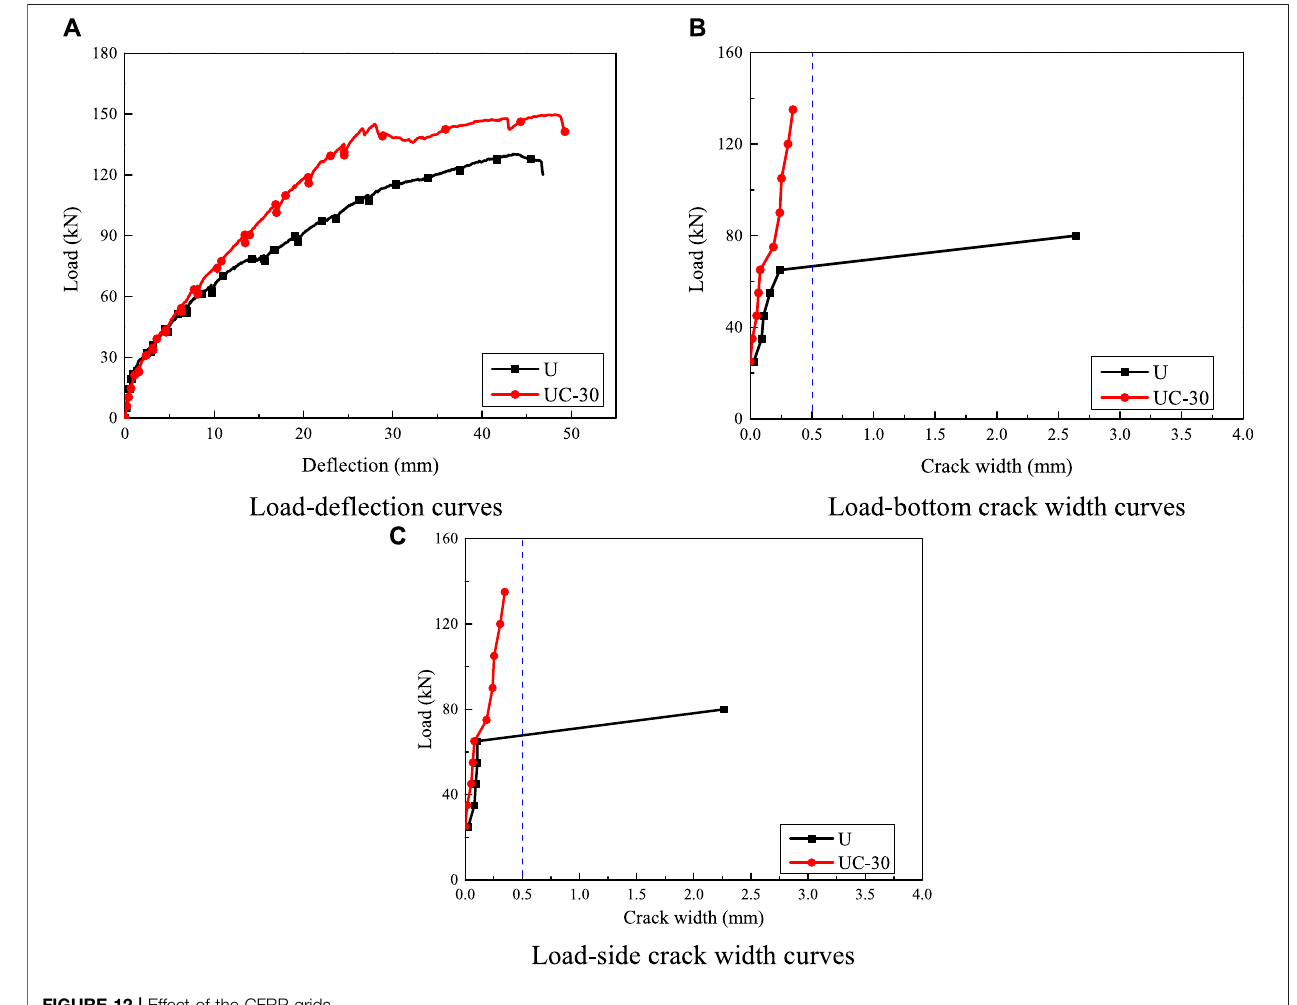
FIGURE 12 | Effect of the CFRP